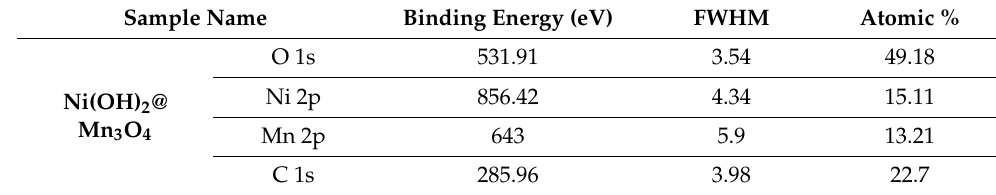
Table 1. FWHM, atomic percentages, and the binding energy (eV) for the prepared